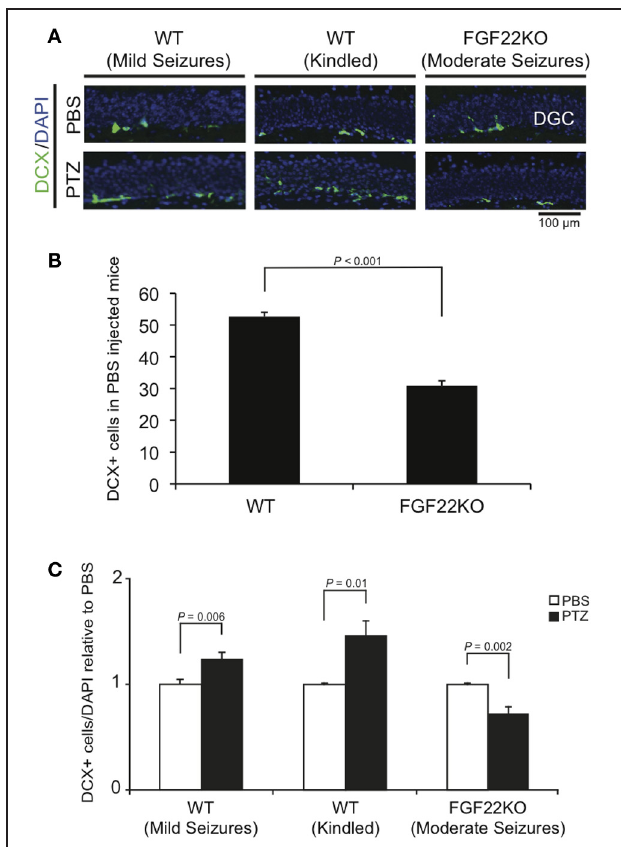
FIGURE 3 | The number of immature neurons in the DG is increased in WT mice with mild and kindled seizures, but is decreased in FGF22KO mice with moderate seizures. Region-matched sagittal hippocampal sections were prepared from PBS- and PTZ-injected WT and FGF22KO mice (3 groups of mice as shown in Figure 1 ) and stained for doublecortin (DCX), a marker for immature neurons. (A) DCX positive cells (green) with DAPI (blue) in the DG of PBS- or PTZ-injected mice. (B) Quantification of the numbers of DCX-positive cells in the DGC layer per section in PBS-injected WT and FGF22KO mice. (C) Quantification of the percentages of DCX-positive cells in DGCs. Data are normalized against corresponding PBS controls. Neurogenesis, as reflected by the percentage of DCX-positive cells, was significantly increased in WT mice with mild and kindled seizures, but was decreased in FGF22KO mice with moderate seizures upon PTZ-injections. Bars are mean ± s.e.m. Student’s t -test P -values are indicated.